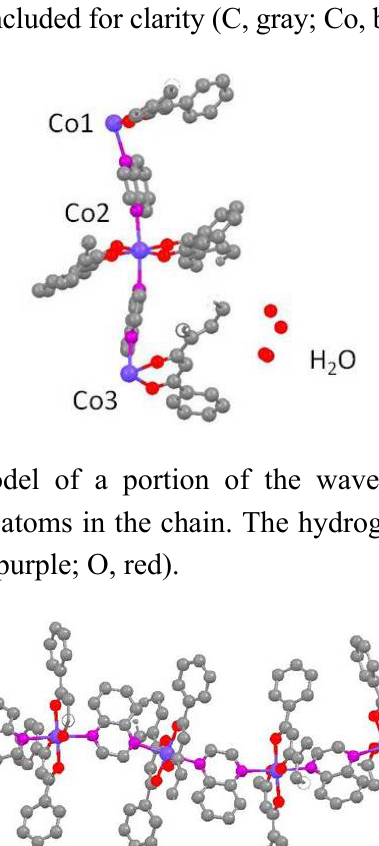
(qox)] ·nH O ( 2 ), showing the 2 n 2